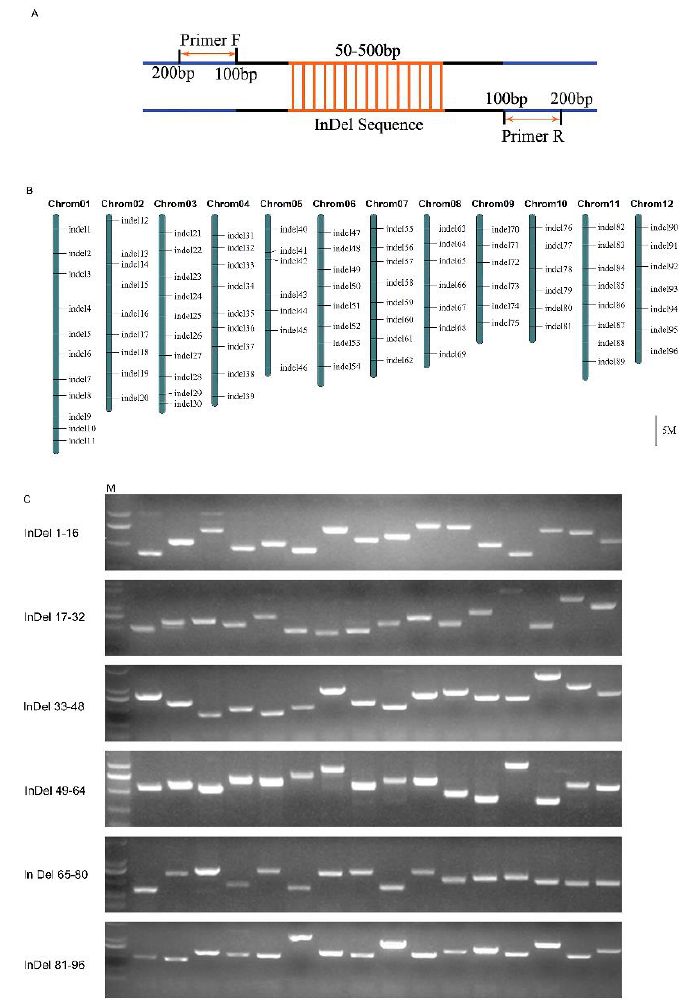
Figure 2. Detection of the amplification efficiency of 96 pairs of primers. ( A ) Schematic diagrams of PCR amplification of the InDel sequence. The primers designed at the position 100–200 bp upstream and downstream. Orange arrows indicate the primer design position. ( B ) The relative distribution of 96 InDel markers on 12 chromosomes of Nipponbare genome. ( C ) PCR amplification with 96 InDel markers. M: DL2000, DNA marker.